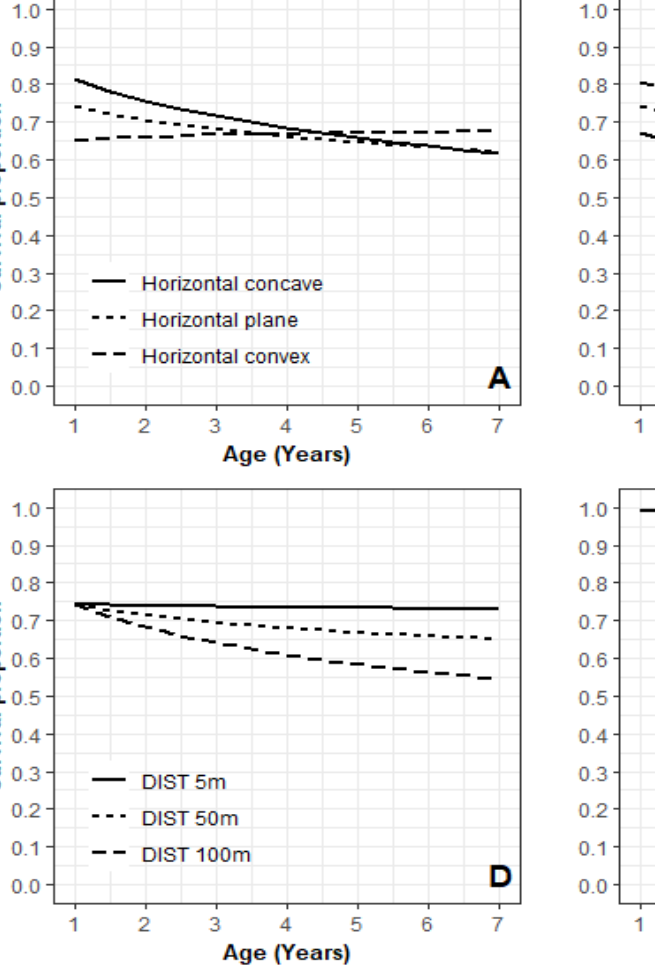
Figure 6. Topographic effects on E. globoidea survival at Site A. ( A ) Effect of plan curvature, ( B ) effect of profile curvature, ( C ) effect of wind exposure index, ( D ) effect of distance from the ridge top, and ( E ) E. bosistoana survival with the effect of profile curvature at site C.